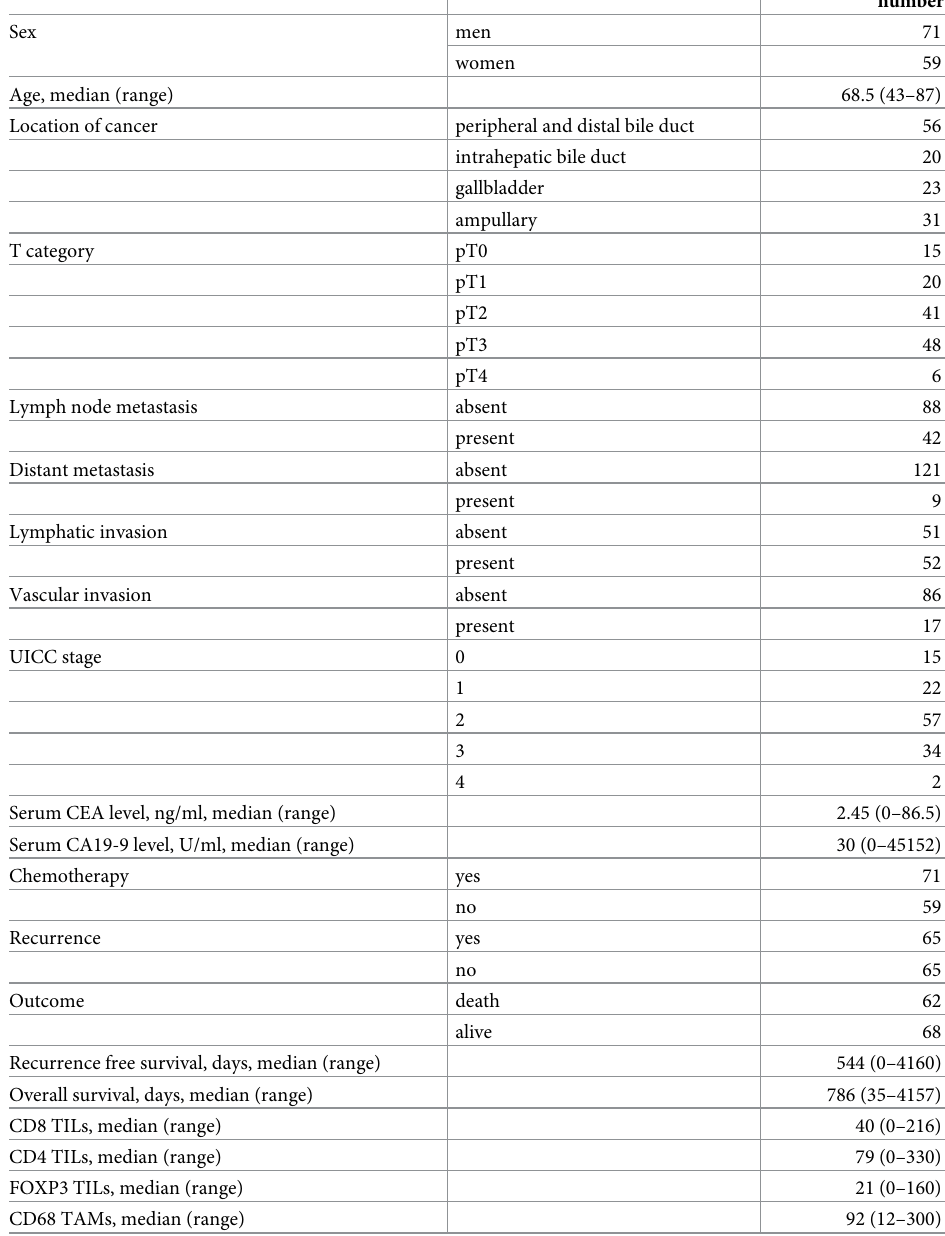
Table 1. Clinicopathological characteristics of 130 patients with